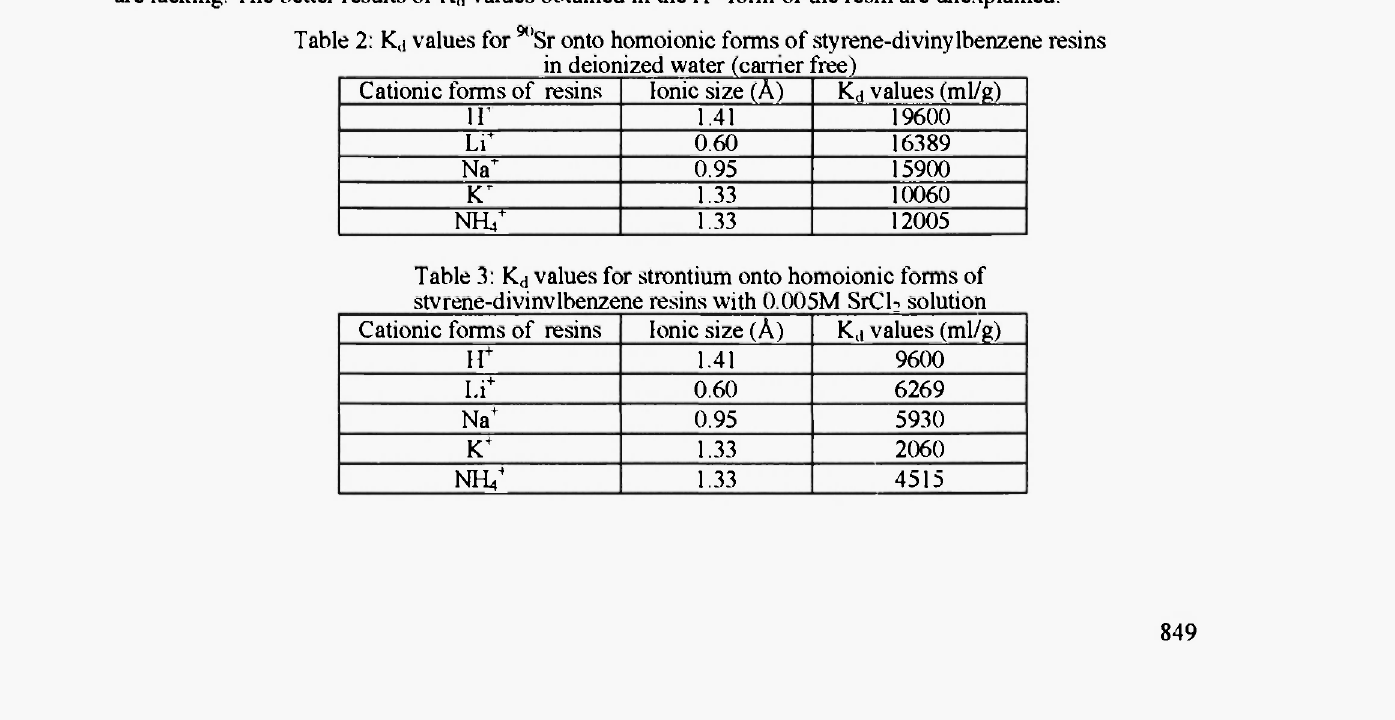
Table 2: K,i values for ^'Sr onto homoionic forms of styrene-divinylbenzene resins in deionized water (earner free)